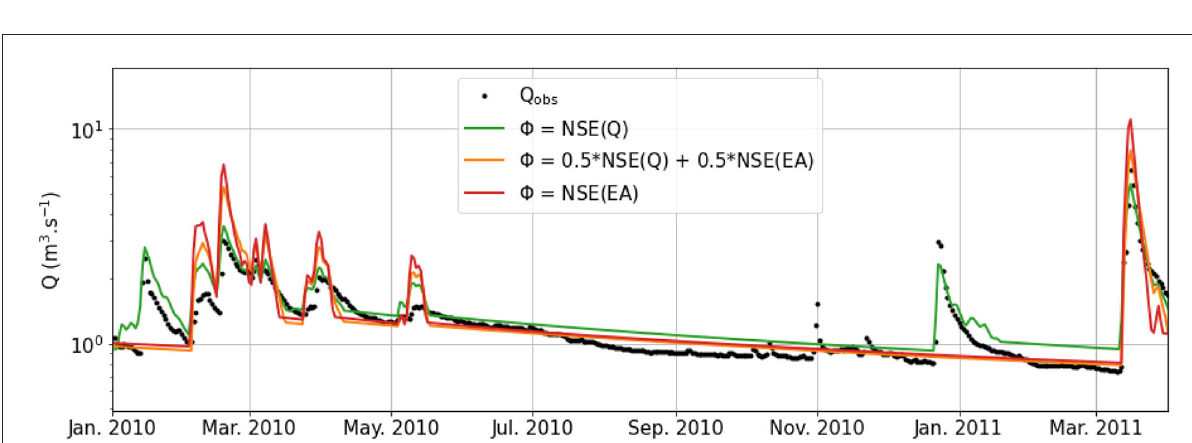
FIGURE8 Observed and simulated spring discharge time series considering different objective